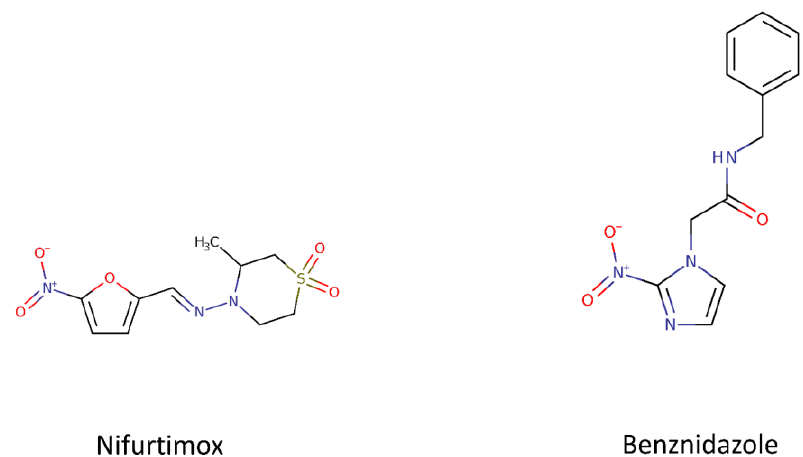
Figure 1. Chemical structures of the two nitroheterocyclic compounds developed for Chagas disease. The chemical structure of Nifurtimox and Benznidazole were retrieved from Drug Bank (http: // www.